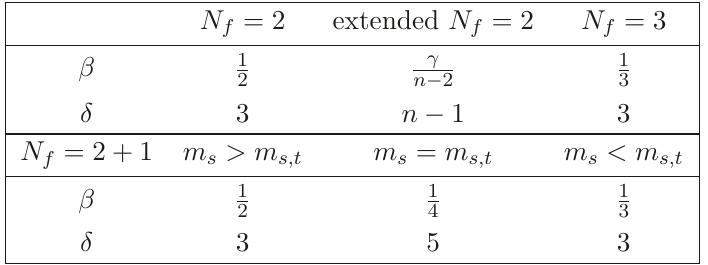
Table 1 . Summarization of critical exponents in different cases from soft-wall AdS/QCD model. Except for the tri-critical point (only numerical result), all the results are exact values checked by analytical analysis in the